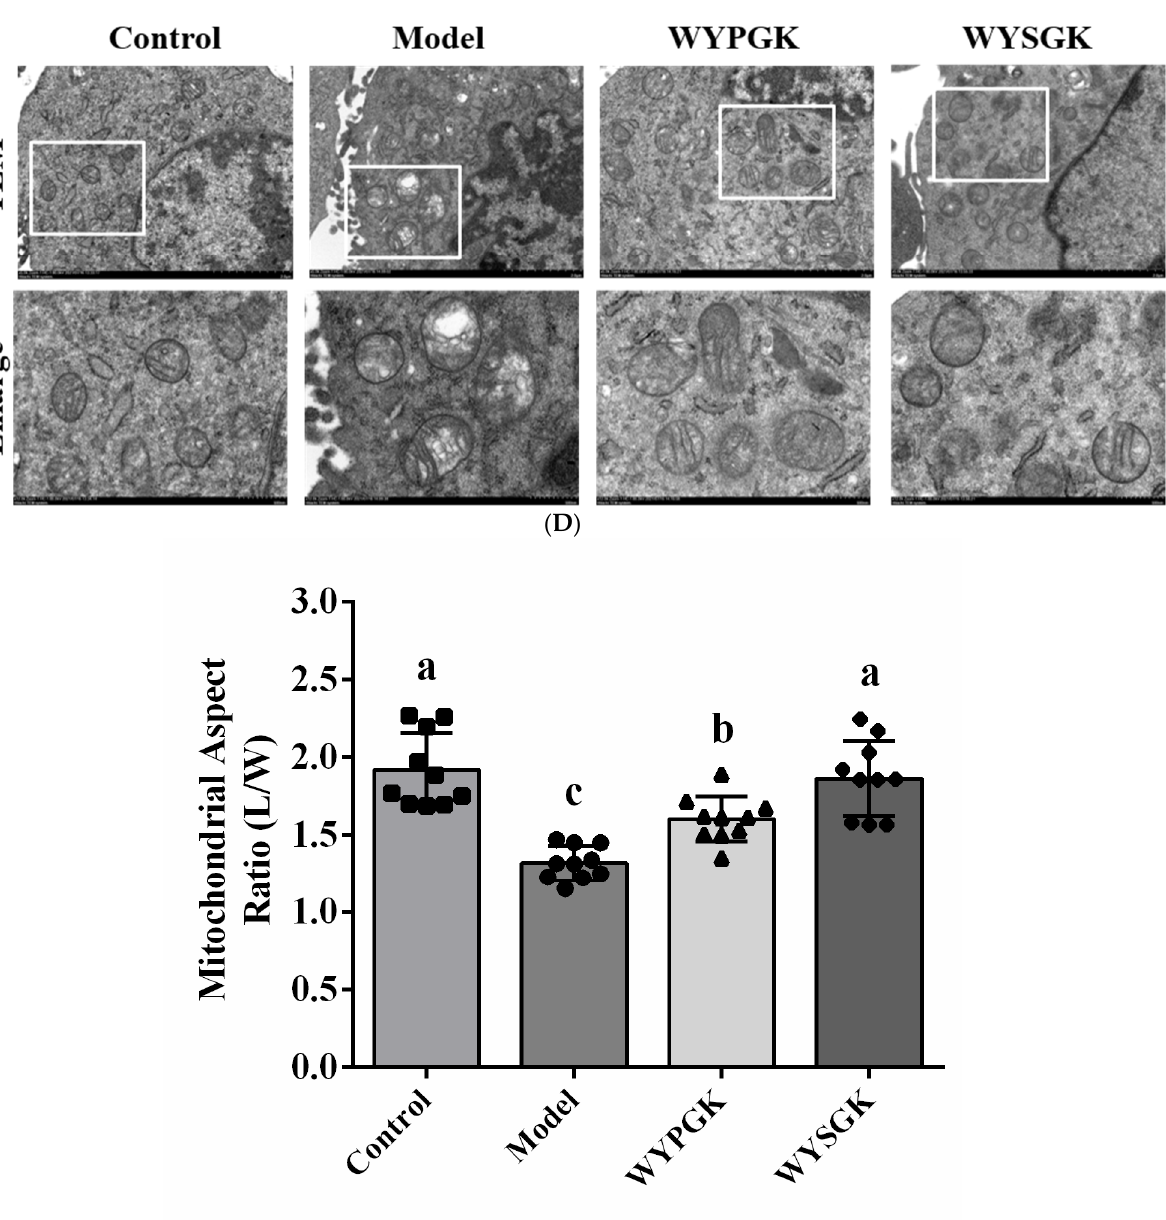
Figure 4. Effects of WYPGK and WYSGK on ( A ) ROS level; ( B ) MDA level; ( C ) ATP level; ( D ) mitochondrial structure and morphology; ( E ) mitochondrial aspect ratio. Representative quantitative results of mitochondrial length with 10 mitochondria per experiment. Data are presented as means ± SD from three replicates. Different letters denote statistically significant differences ( p < 0.05).